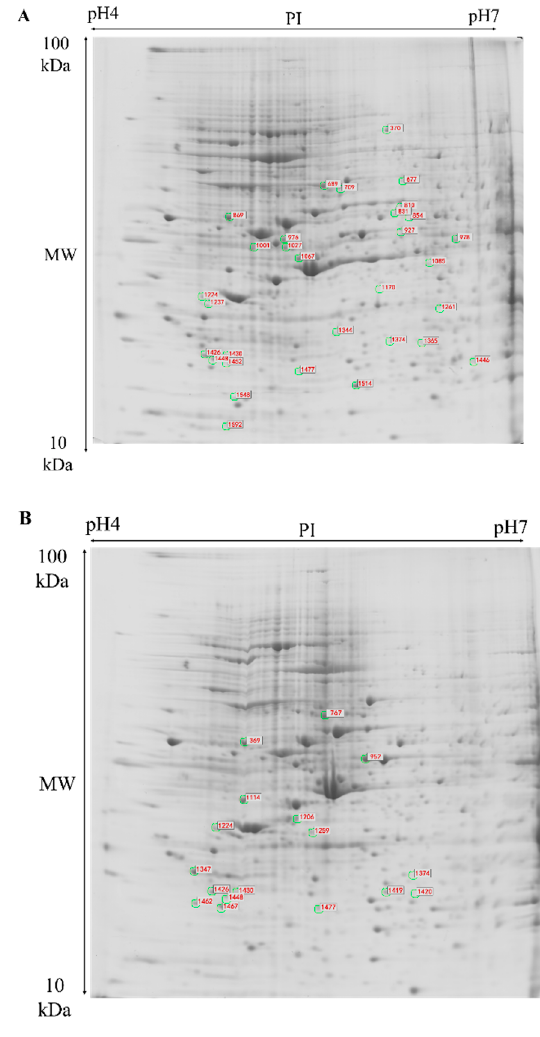
Figure 2. Two-dimensional electrophoresis of the total-cell proteins of HT-29 cells ( A ) and NCM460 cells ( B ) treated with SCS. Differentially expressed protein spots of cells treated with SCS were numbered according to the numbering in Table 2.